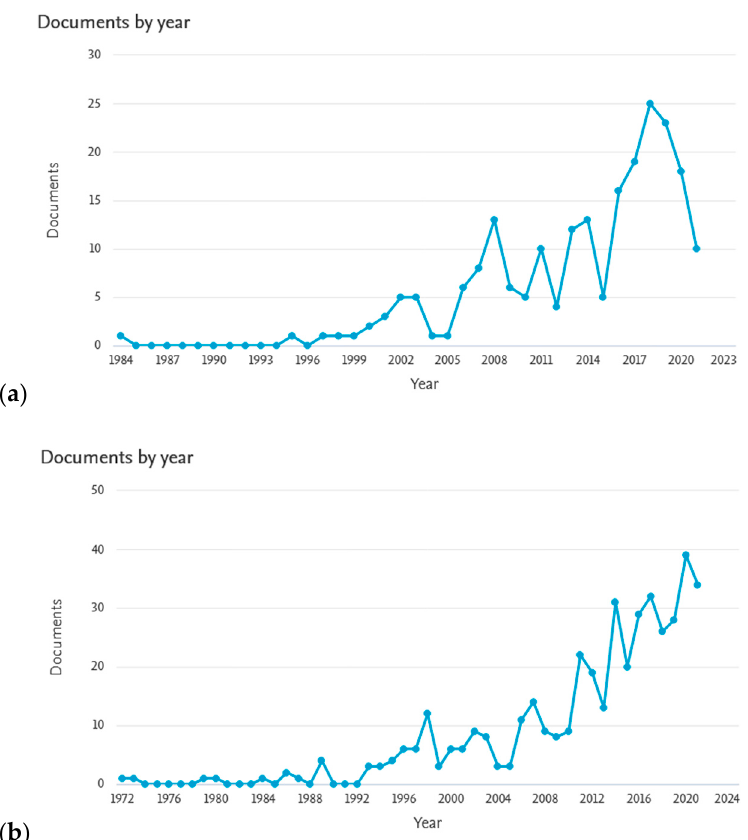
Figure 1. Scopus search data analysis for ( a ) “ Seismic design ” AND “ Steel joints ” OR “ Steel Connec- tions ” OR “ Bolted connections ” OR “ Bolted joints ” and ( b ) “ Earthquake ” AND “ Steel joints ” OR “ Steel Connections ” OR “ Bolted connections ” OR “ Bolted joints ” in Title, Keywords or Abstract in Research, Review and Conference articles, on 1 November 2021.